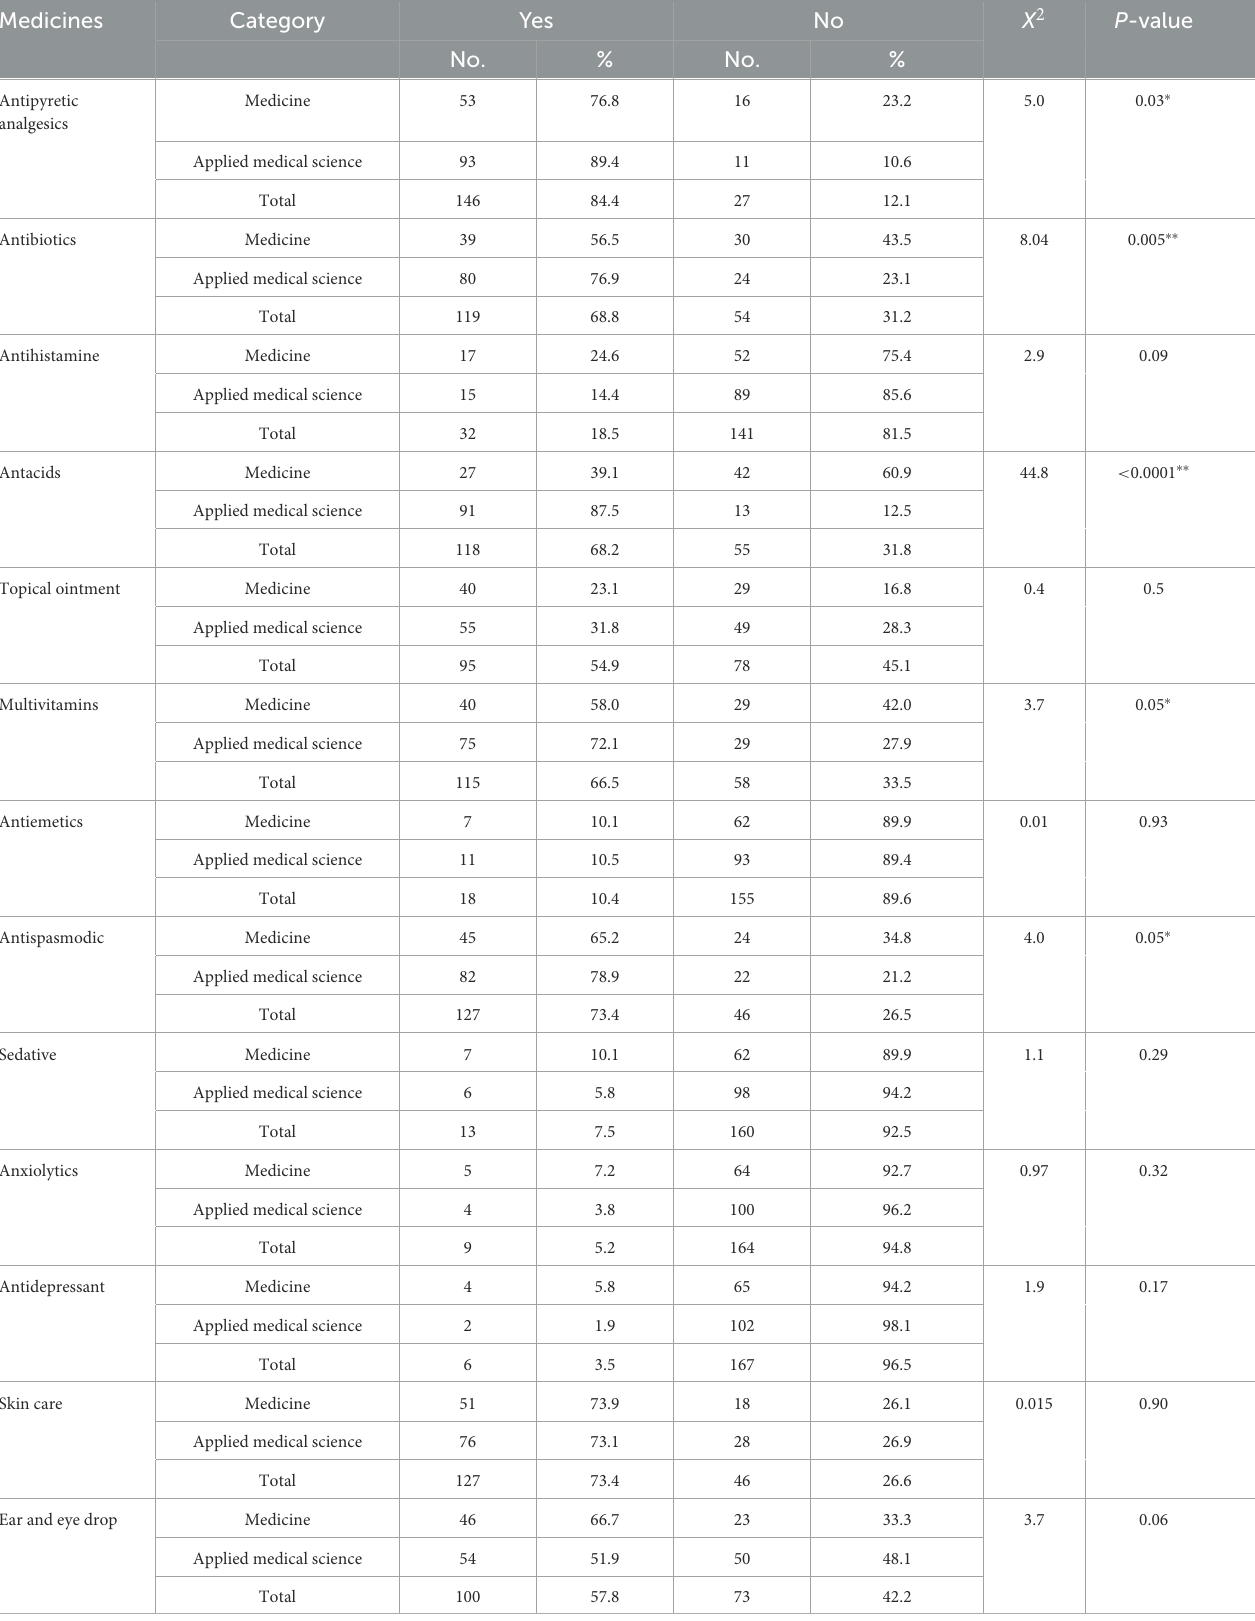
TABLE 4 Medications used for self-medication ( N =